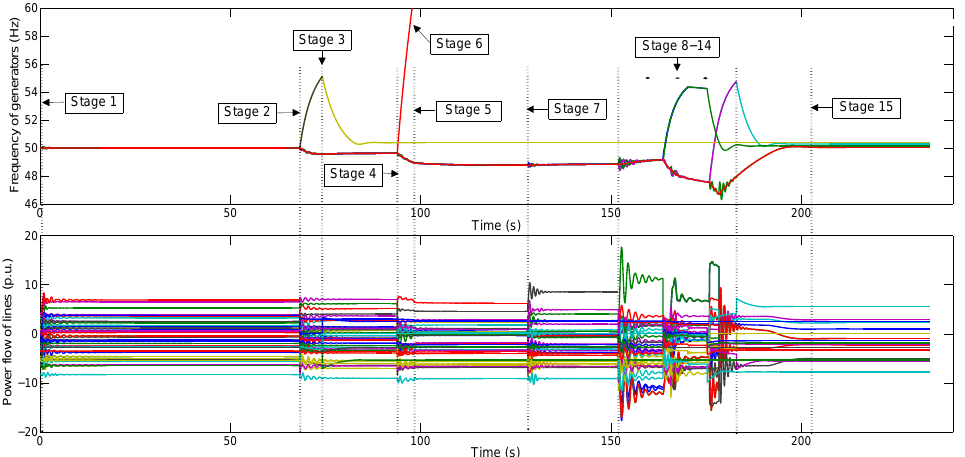
Figure 7. Dynamics of generator frequency and branch power flow after initial outages of branches 10–11 and